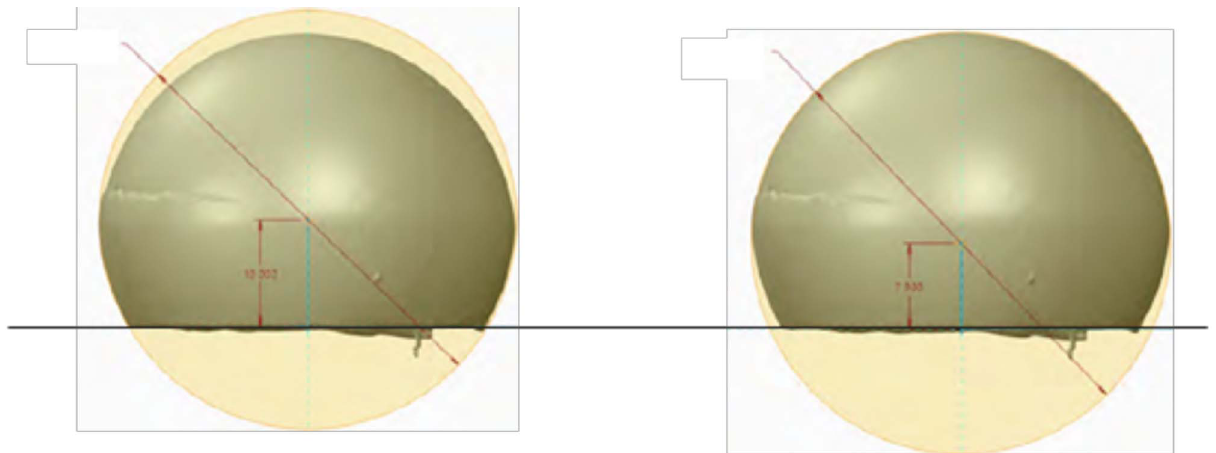
Figure 4. Linear wear of the large articulation was 2.1